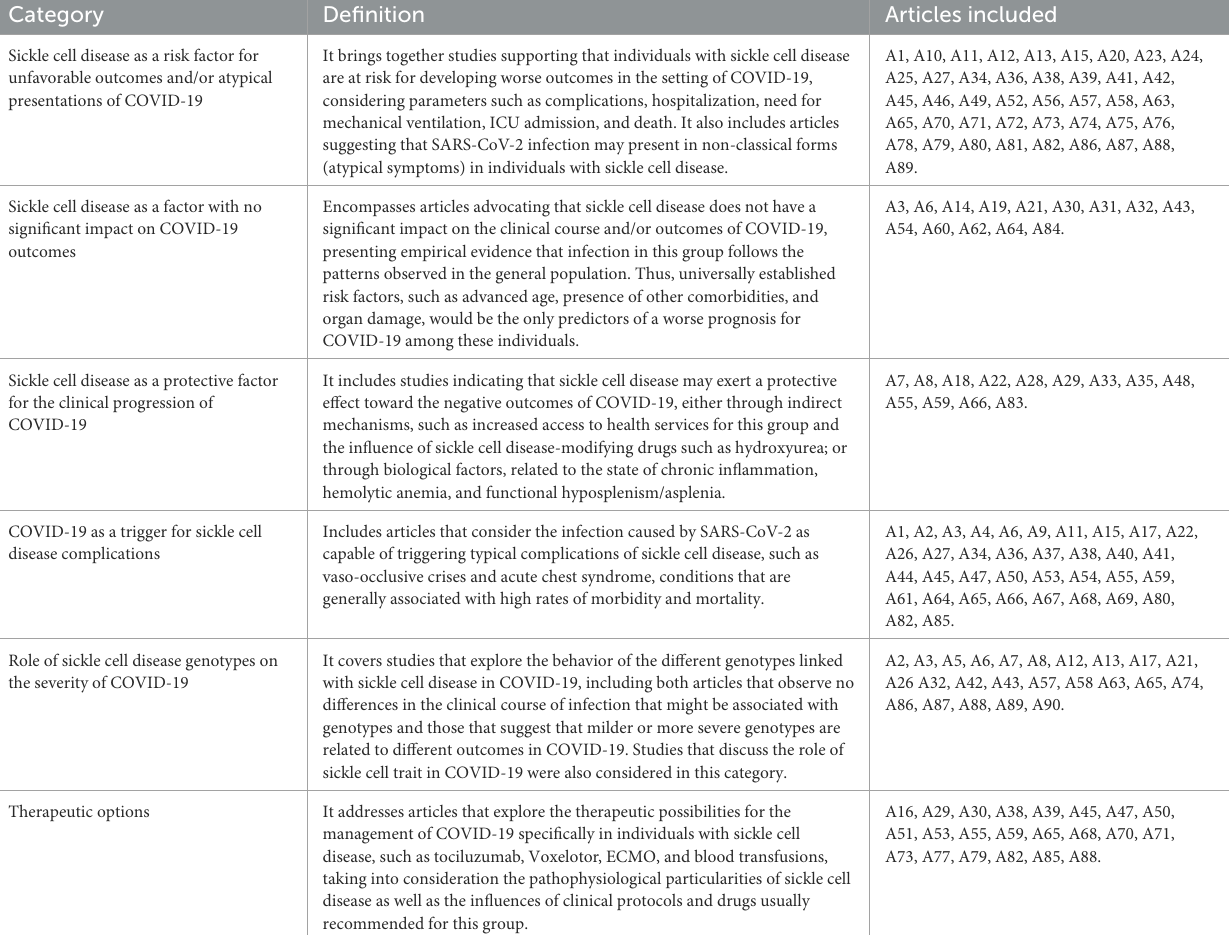
TABLE 4 Organization of the included studies into